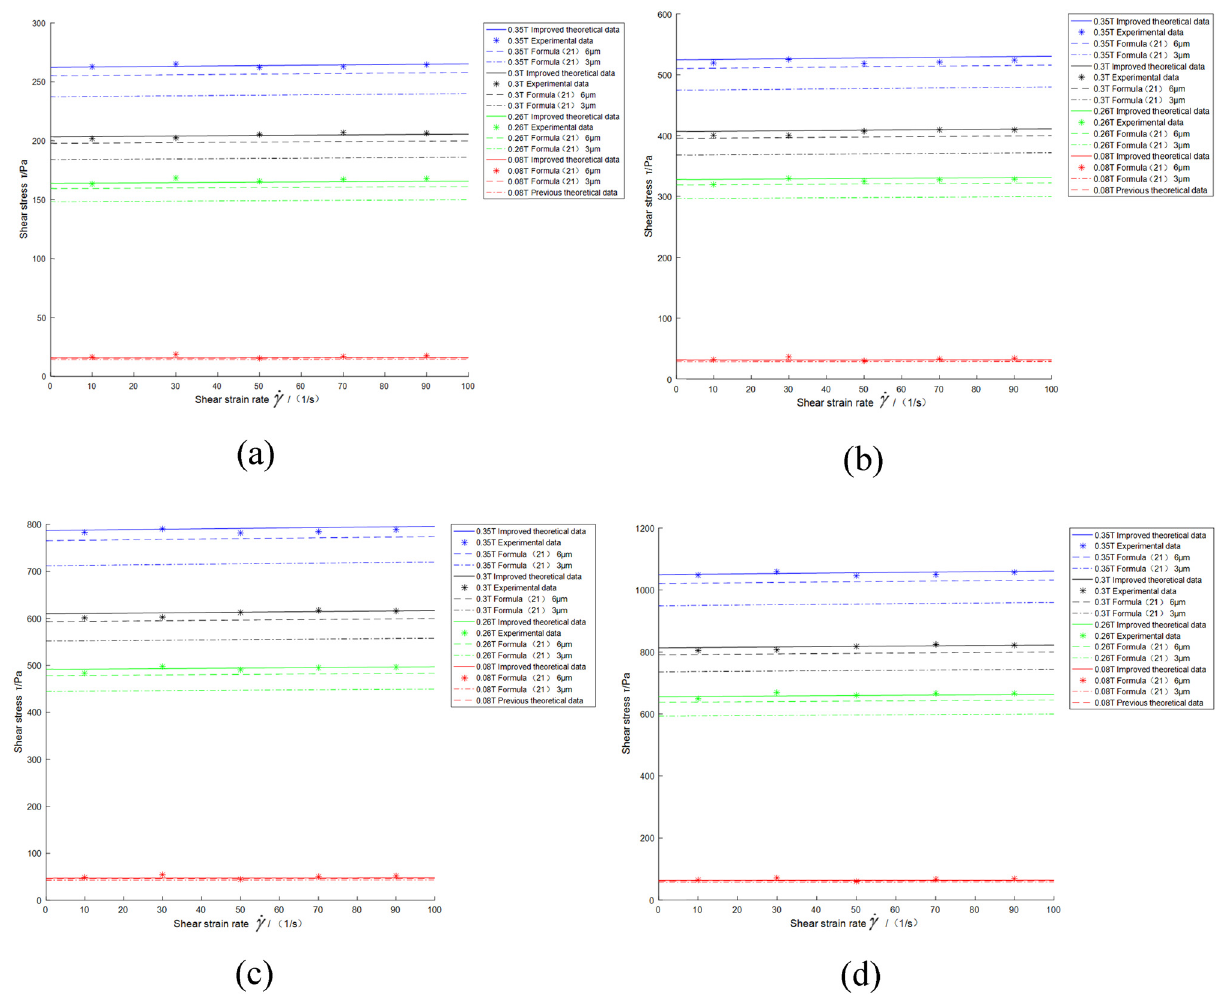
Figure 7: When the particle volume fraction is constant ， the relationship between shear strain rate and shear stress under di ff erent magnetic induction intensities graph: ( a ) particle volume fraction is 5%; ( b ) particle volume fraction is 10%; ( c ) particle volume fraction is 15%; and ( d ) particle volume fraction is